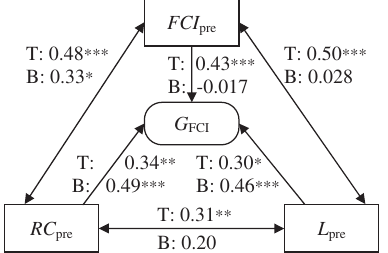
FIG. 8. Spearman’s rank correlation between single student normalized FCI gain ( G FCI ) and the three pretest variables: representational consistency on the R-FCI ( RC pre ), the FCI score ( FCI pre ), and the Lawson score ( L pre ). Students were placed into the top ( T , n ¼ 71 ) or bottom ( B , n ¼ 60 ) half according to their L pre . (cid:5) p < 0 : 05 , (cid:5)(cid:5) p < 0 : 01 , (cid:5)(cid:5)(cid:5) p < 0 : 001 .